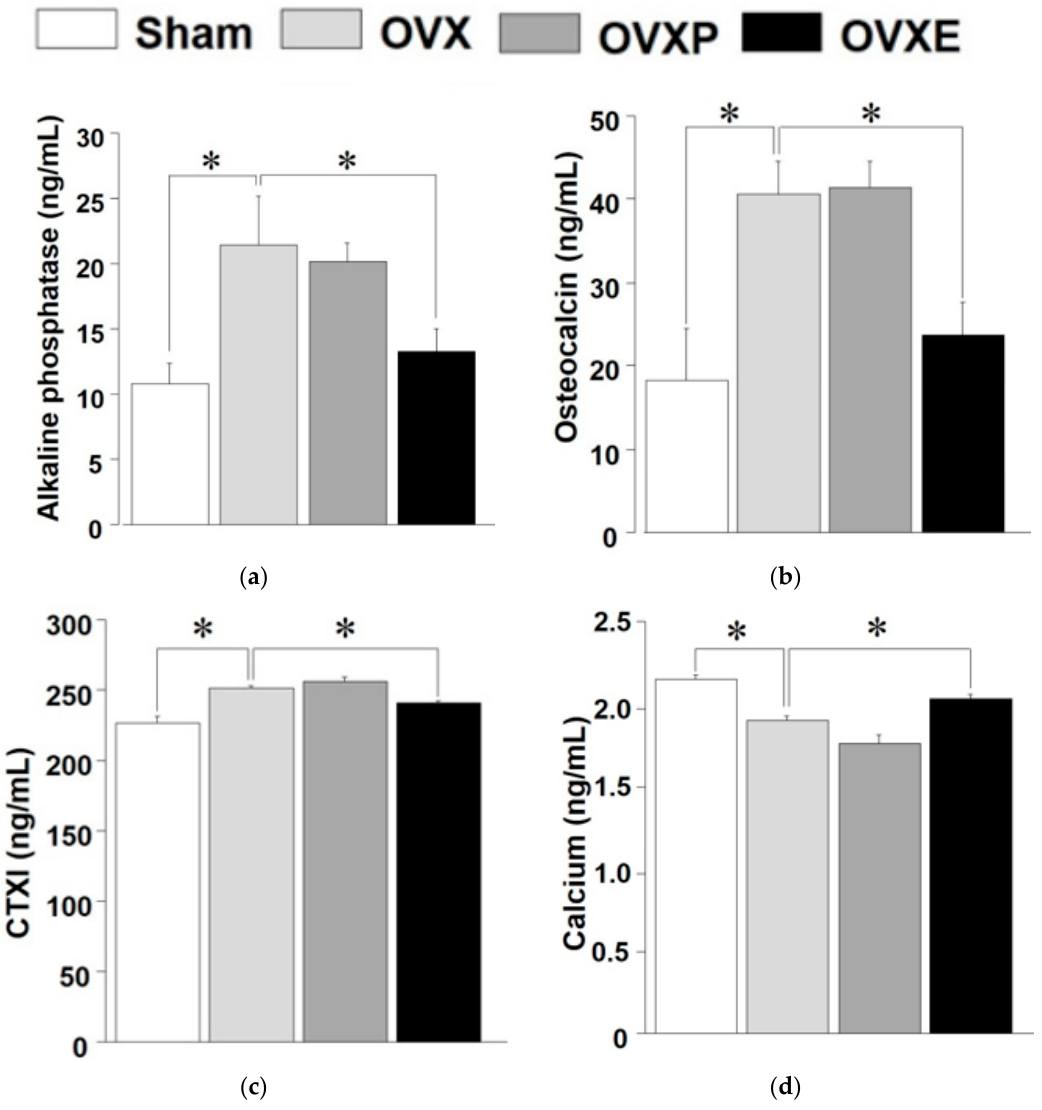
Figure 7. ELISA analysis of bone markers. ( a ) Alkaline phosphatase (ALP), ( b ) osteocalcin, ( c ) C-telopeptide cross-linked collagen type I (CTXI), and ( d ) calcium. * p < 0.05.